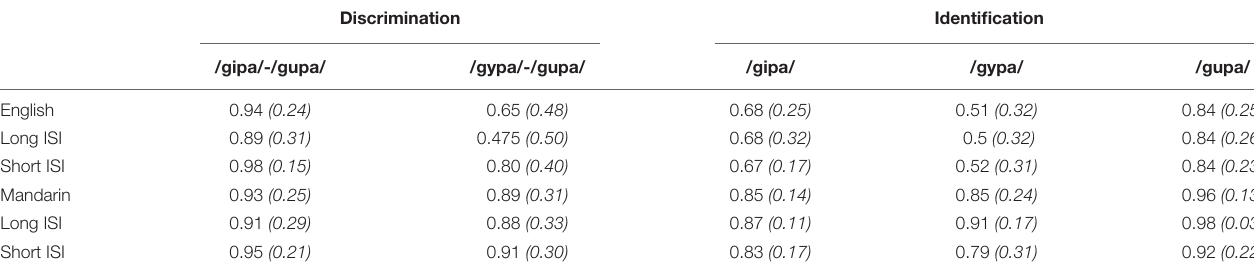
TABLE 3 | Means (SD) of vowel discrimination accuracy and vowel identification under four language/interstimulus (ISI) groups.